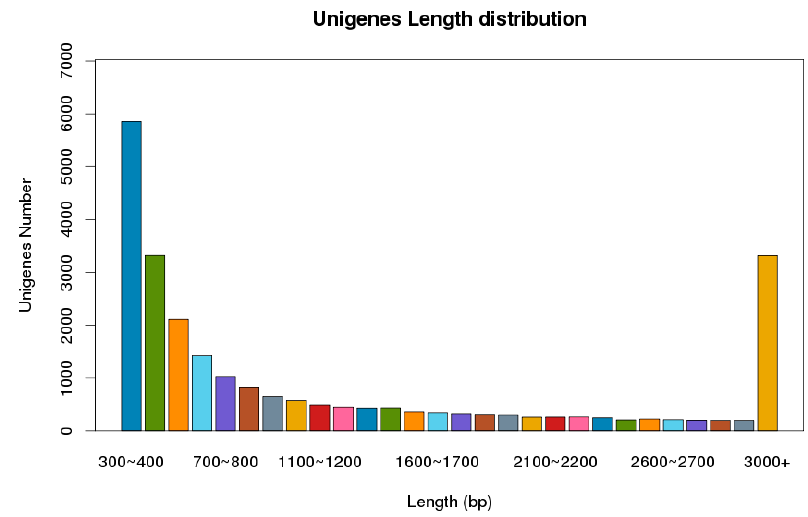
Figure 1. Distribution of unigene size in the P. versicolora transcriptome assembly.